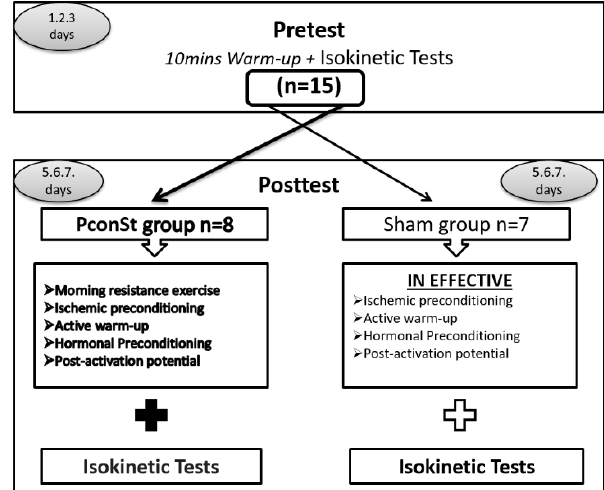
Fig 1 . Study design: Pretest and PconSt protocols with test procedures and the intervention phase.